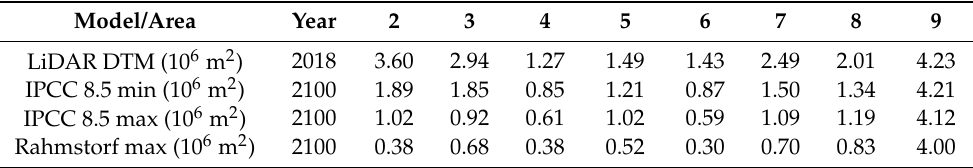
Table 7. Values of emerged surfaces of the eight sub-areas outside the to the levees taking into account prevision of the RSLR scenarios by 2100 based on the IPCC 8.5 min and max, and [51] max models in